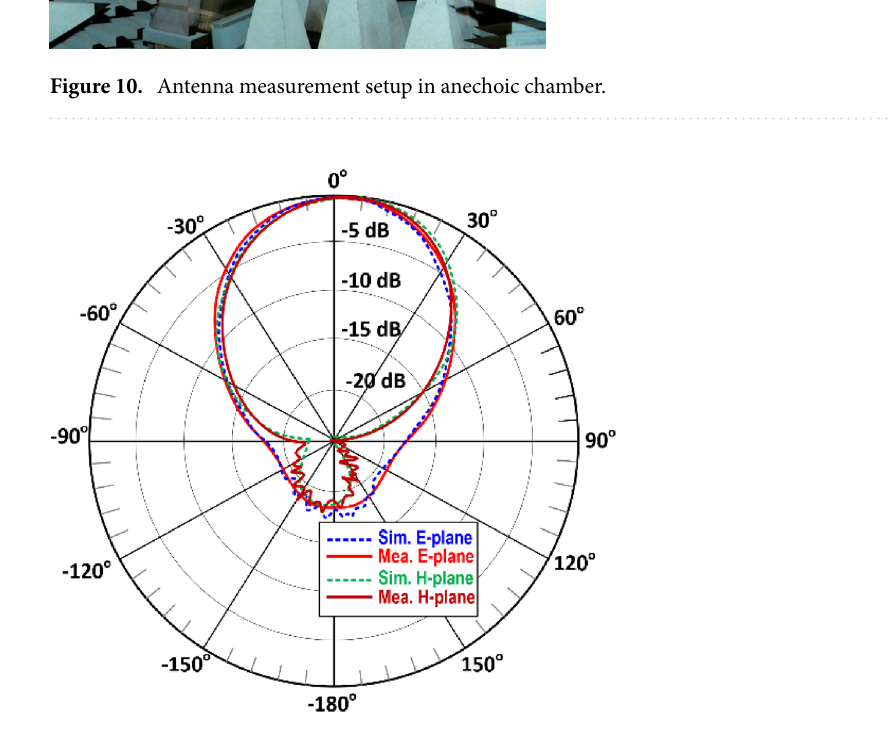
Figure 11. Normalized simulated and measured radiation pattern of the single antenna in E and H-planes at 4.25